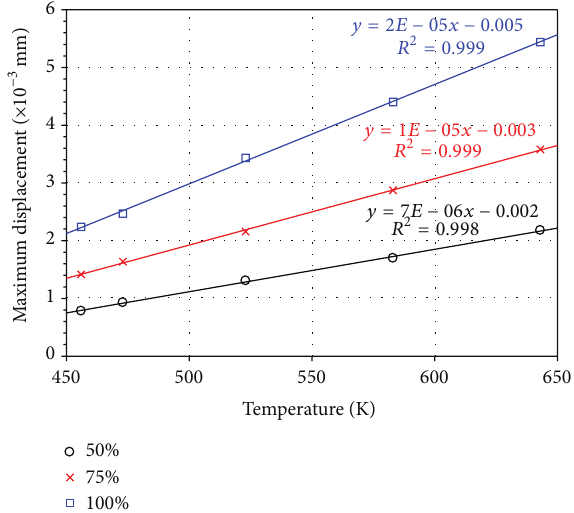
Figure 14: Maximum displacement of PTH at 50%, 75%, and 100%